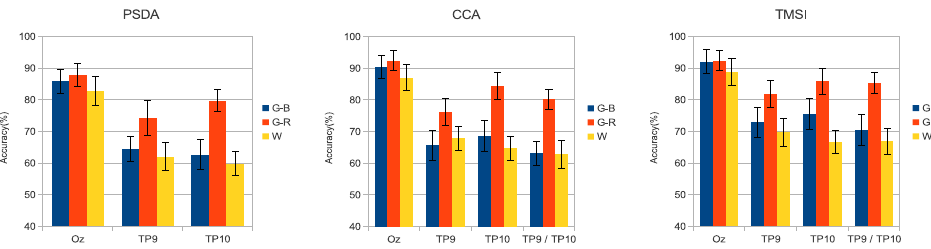
Figure 6. Average accuracy of all volunteers for the three stimuli in medium-frequency range. Error bars indicate standard errors. CCA: canonical correlation analysis; TMSI: temporally local multivariate synchronization index.